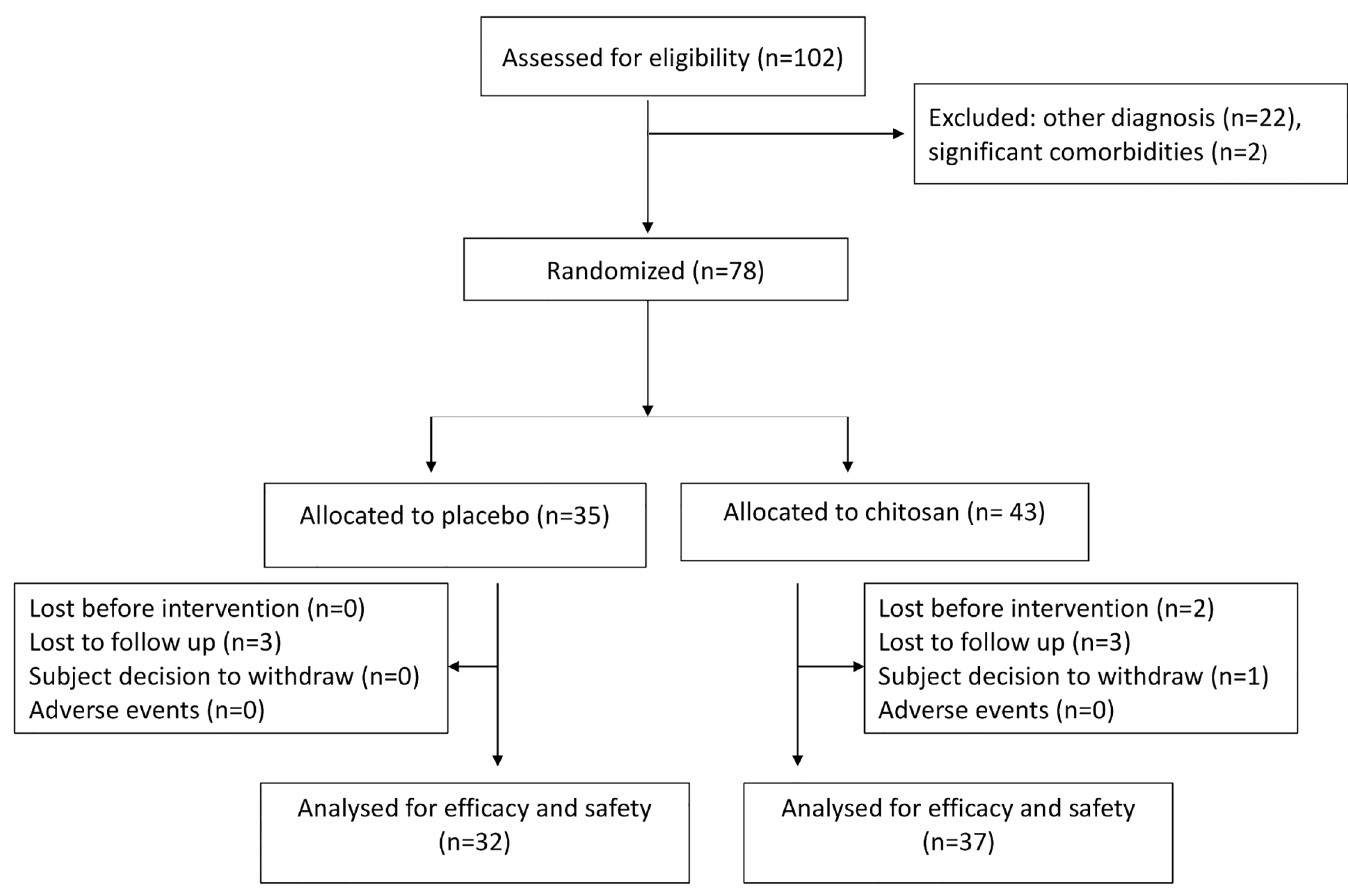
Fig 1. Flow chart of participants through the